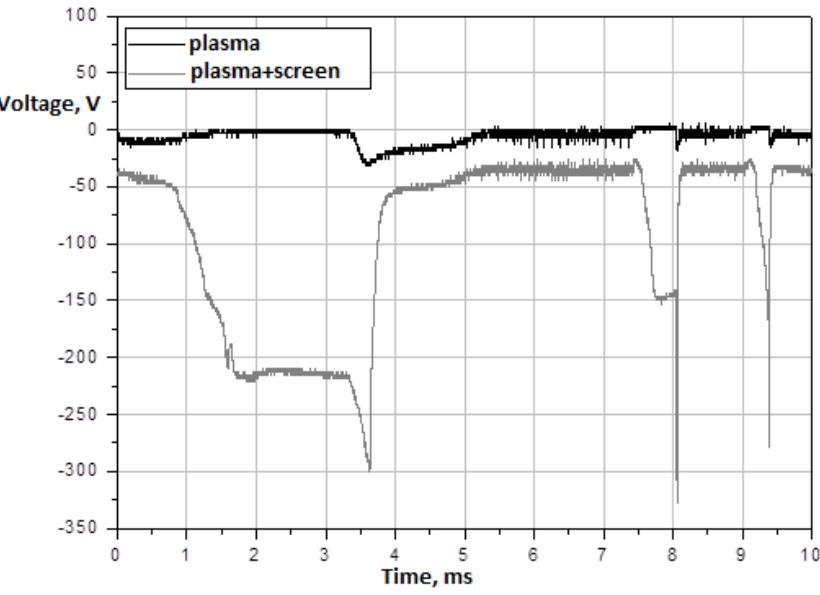
Figure 16. Comparison of voltage waveforms at the surface of the screened sample (bottom) and the unscreened sample (top), which have no galvanic contact with the cathode. A time base of 10